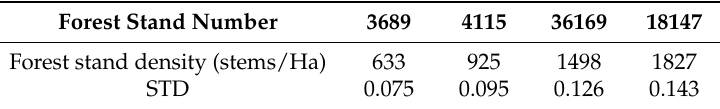
Table 4. Discrete degree of phase centers for different forest